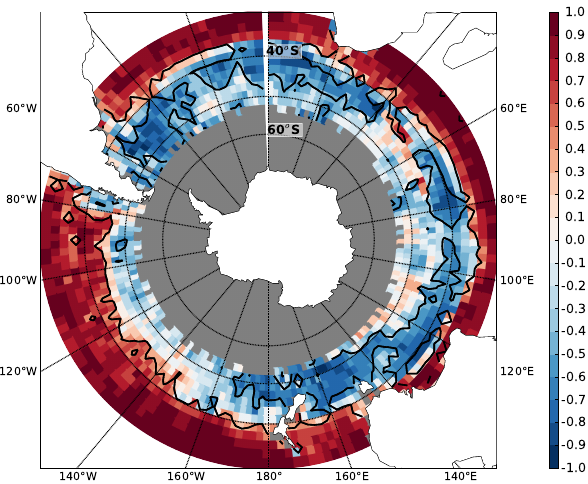
Fig. 7. Pearson’s correlation coefficient between seasonal cycles of monthly MLD from the De Boyer Mont´egut et al. (2004) dataset and chlorophyll. Masked grid-points in grey correspond to ar- eas where more than half the monthly values were missing in the chlorophyll time series. Correlations are statistically significant at the 99% confidence